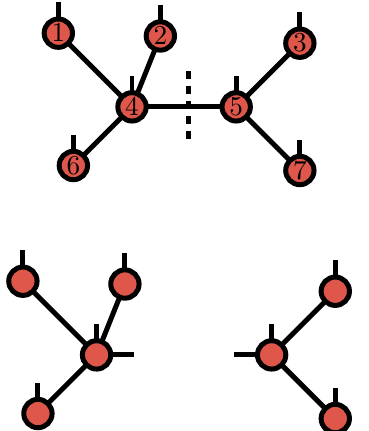
Figure 1: Example of a TTN with 7 tensors with different numbers of link-indices on each site. Each dot represents a tensor and each line an index, where a connected line implies summation over this index. The open lines are the physical indices s ( N = 7), while the connected lines are the link indices q link between sites 4 and 5, as indicated by the dashed line, results in two disconnected tensor network segments and defines a notion of left and right at each link. In this example, sites 1, 2, 3, 6 and 7 are the leaves of the